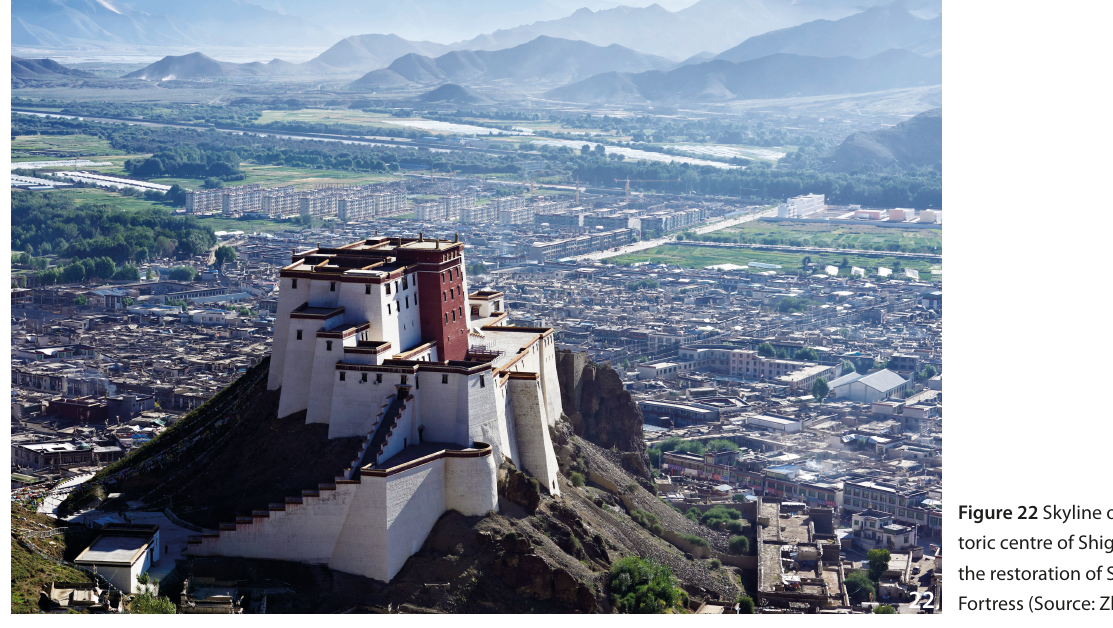
Figure 22 Skyline of the his- toric centre of Shigatse after the restoration of Sangzhutse Fortress (Source: Zhang Siye).